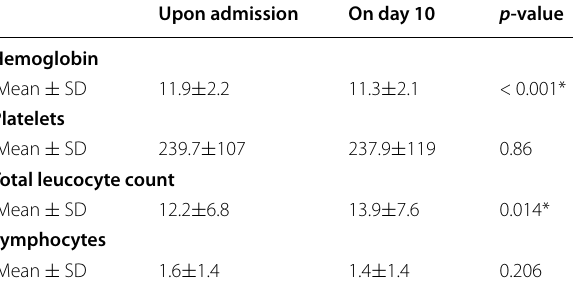
age of the patients included in the study was (64.7 14.7) years.